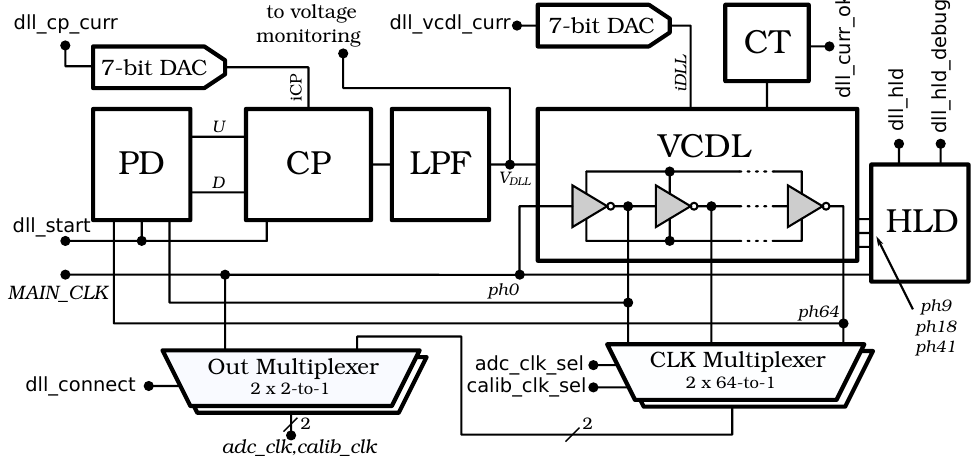
Figure 4. Delay-Locked Loop (DLL) block diagram: PD—Phase Detector, CP—Charge Pump, LPF—Low Pass Filter, VCDL—Voltage Controlled Delay Line, CT—Current Test, HLD—Harmonic Lock